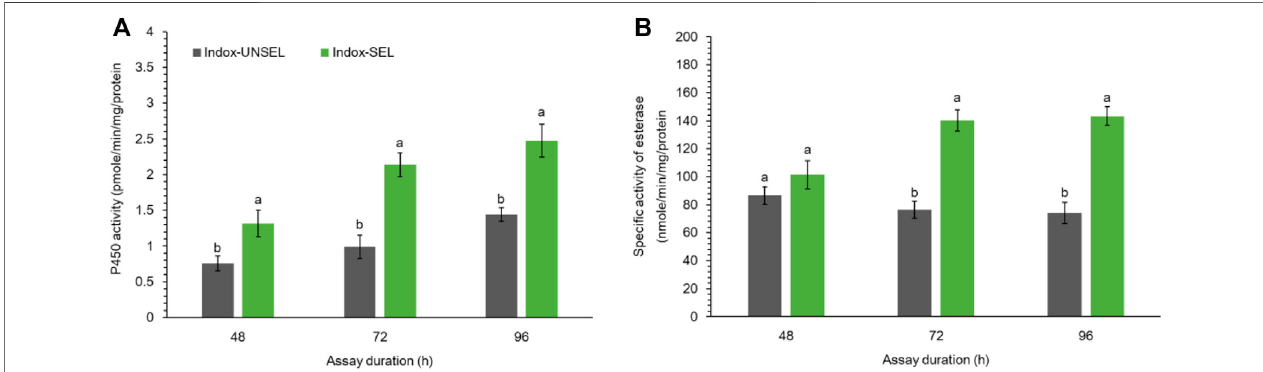
FIGURE1| ActivityofP450enzyme (A) andspeci fi cactivityofesterase (B) inmidgutsofthefourth-instarlarvaeofIndox-UNSELandIndox-SELpopulationofFAW after48,72and96 hexposuretoLC 20 (6.84 μ g g − 1 )concentrationofindoxacarb. Thedatawereexpressedasthemeans±SE.Thebarswithlowercaselettersindicate signi fi cant differences within the same treatment time at the p < 0.05 level, based on Student ’ s t test.